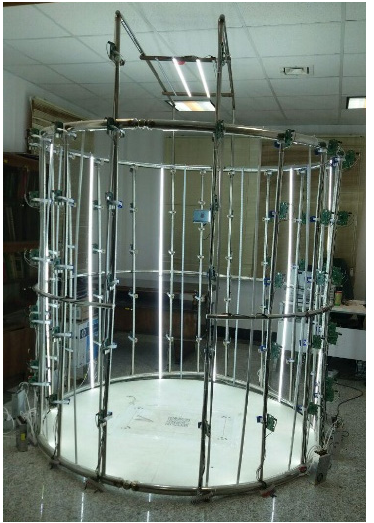
Figure 6. Developed 3D scanning system. Table 2. Hardware costs of the developed human body 3D scanner.